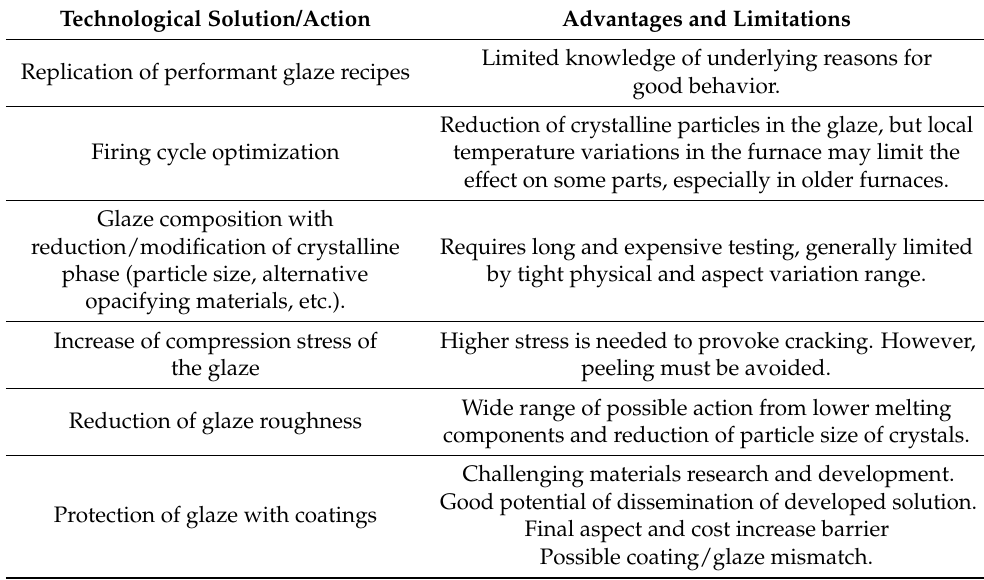
Table 3. General methods to improve metal marking